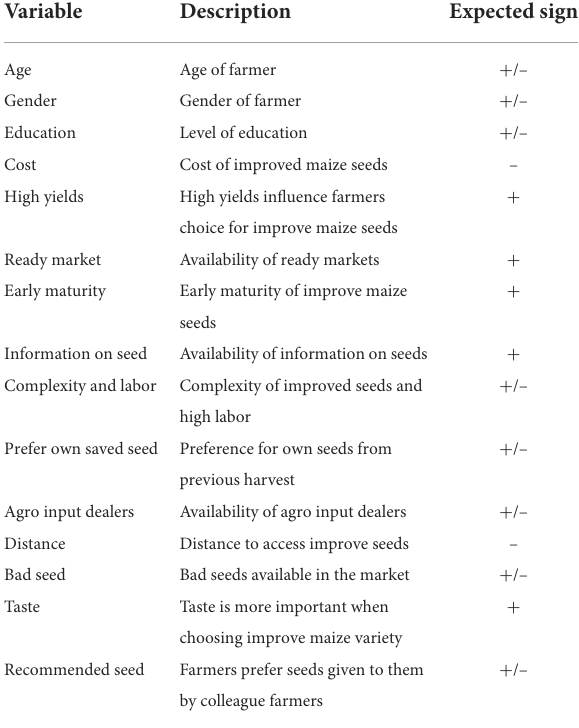
TABLE 2 Description of variables used in the model and the expected